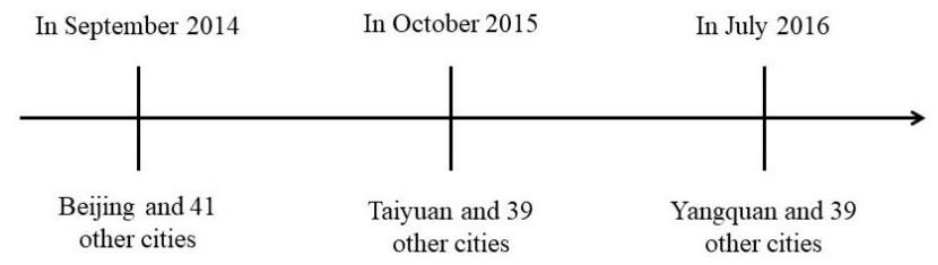
Figure 1. “Broadband China” city development process .